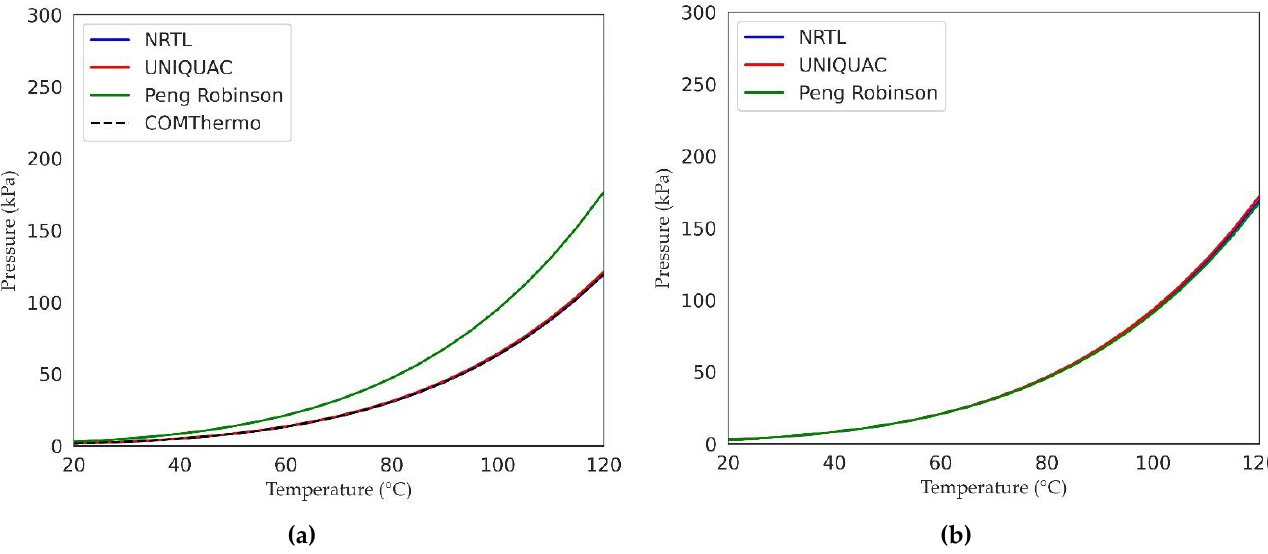
Figure A1. Dew Point Pressure Calculations with Different Thermodynamic models Using ( a ) HYSYS V9 and ( b ) Aspen Plus V9. Note: 0.5 Octane/0.5 water molar fractions.